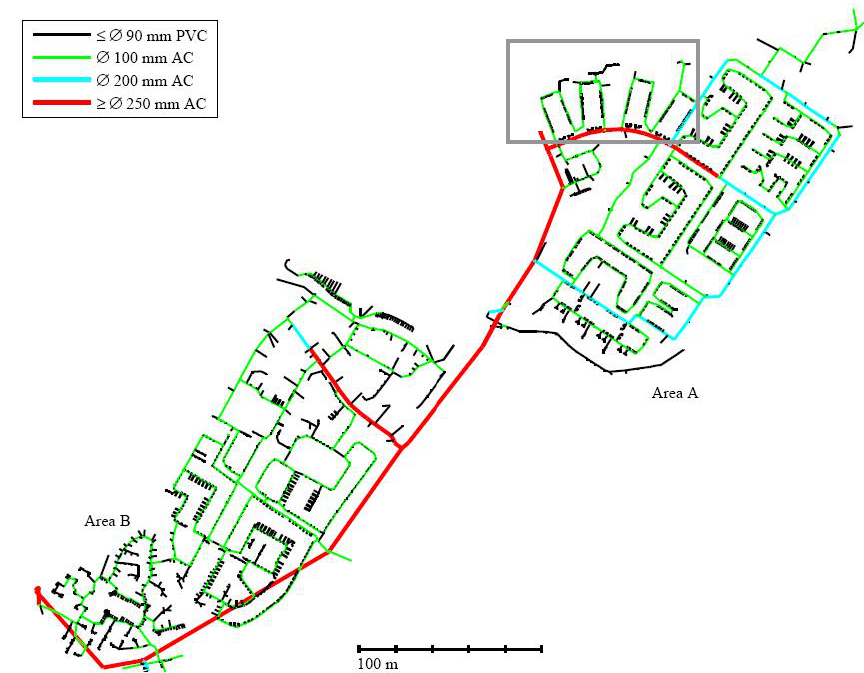
Figure 1: Purmerend DWDS and selected test area (grey rectangle). Source: (Blokker et al., 2010a). 13 Figure 1. Purmerend DWDS and selected test area (grey rectangle). Source: Blokker et al.